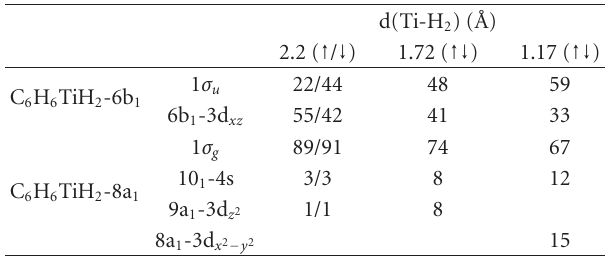
Table 2: C 6 H 6 TiH 2 MOs composition (%). Orbital labels refer to Figure